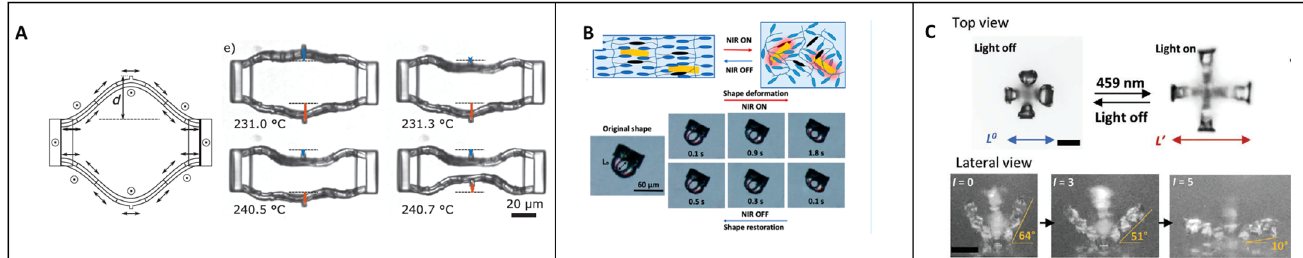
Figure 7. ( A ) Thermal actuation of an electrically aligned micro-object [58]. Reproduced under